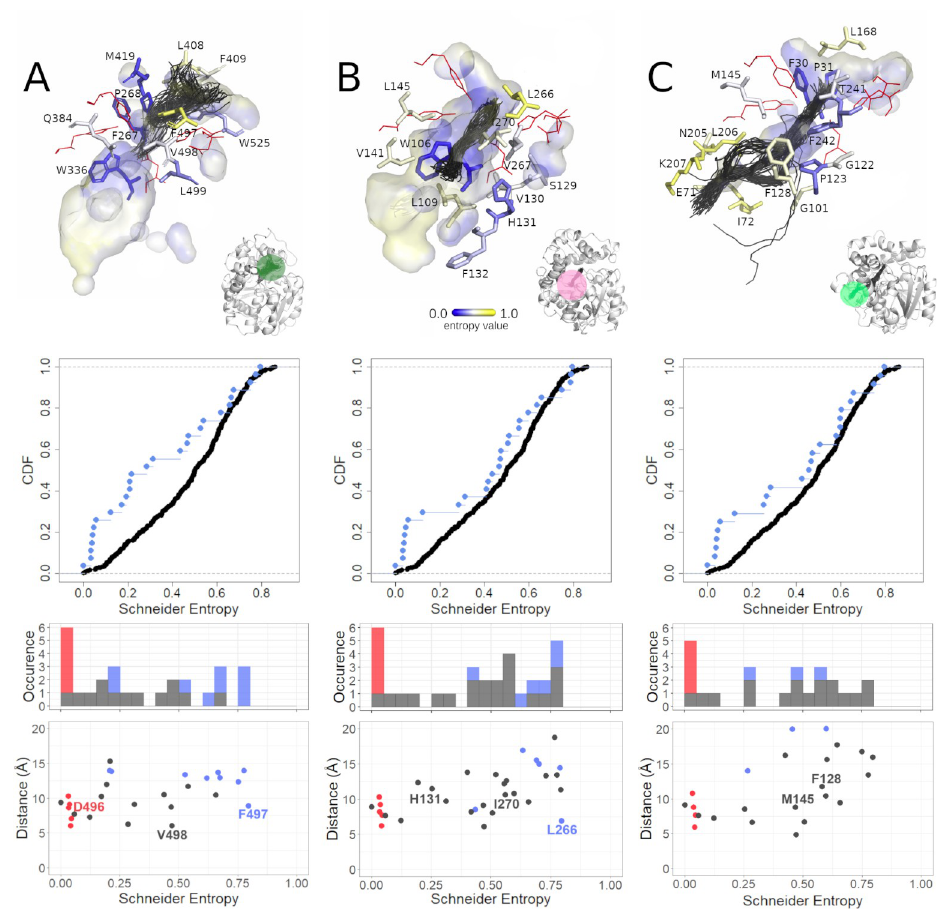
Fig 5. Analysis of the selected tunnels of soluble epoxide hydrolases (sEHs). A) The Tc/m tunnel of the H . sapiens soluble epoxide hydrolase (hsEH) structure, B) the Tm1 tunnel of the S . tuberosum soluble epoxide hydrolase (StEH1) structure, and C) the Tc/m_back tunnel of the B . megaterium soluble epoxide hydrolase (bmEH). Each panel consists of three parts: top section—close-up of tunnel residues. Residues are coloured according to entropy score. For the sake of clarity, less-frequently detected amino acid residues were omitted, and those creating the active site are shown as red lines. The active site cavity is shown as the interior surface, and the representative tunnel detected during molecular dynamics (MD) simulations as centerlines; middle section—cumulative distribution function (CDF) of entropy score for the tunnel-lining residues without the surface residues (cyan dots) and corresponding counterpart (black dots); and bottom section–scatterplot of the tunnel residues’ entropy values relative to distance from the geometric centre of the α carbons of the enzyme, along with a marginal histogram of entropy value counts in respective intervals. Scatterplot points as well as histogram counts grouped into classes based on residue classification (active site–red; surface residues–blue; buried–grey). like shape of the violin plot, when surface residues are included), and nearly flat distribution of entropy values (hourglass-like violin shape, when surface residues are excluded). The majority of the tunnel-lining residues showed relatively high entropy values, while the residues with lower entropy values were located in proximity to the active site. In our previous analysis of StEH1 [49], we identified three residues, namely P188 (Schneider entropy value 0.5117) (not shown in Fig 5), L266 (Schneider entropy value 0.7946), and I270 (Schneider entropy value 0.5594), as potentially useful during protein engineering. Here we present that those residues are also variable, which may suggest that their substitution might not affect protein stability. Interestingly, approximately in the middle of the tunnel length, a less-variable H131 (Schnei- der entropy value 0.2524) residue was also identified.